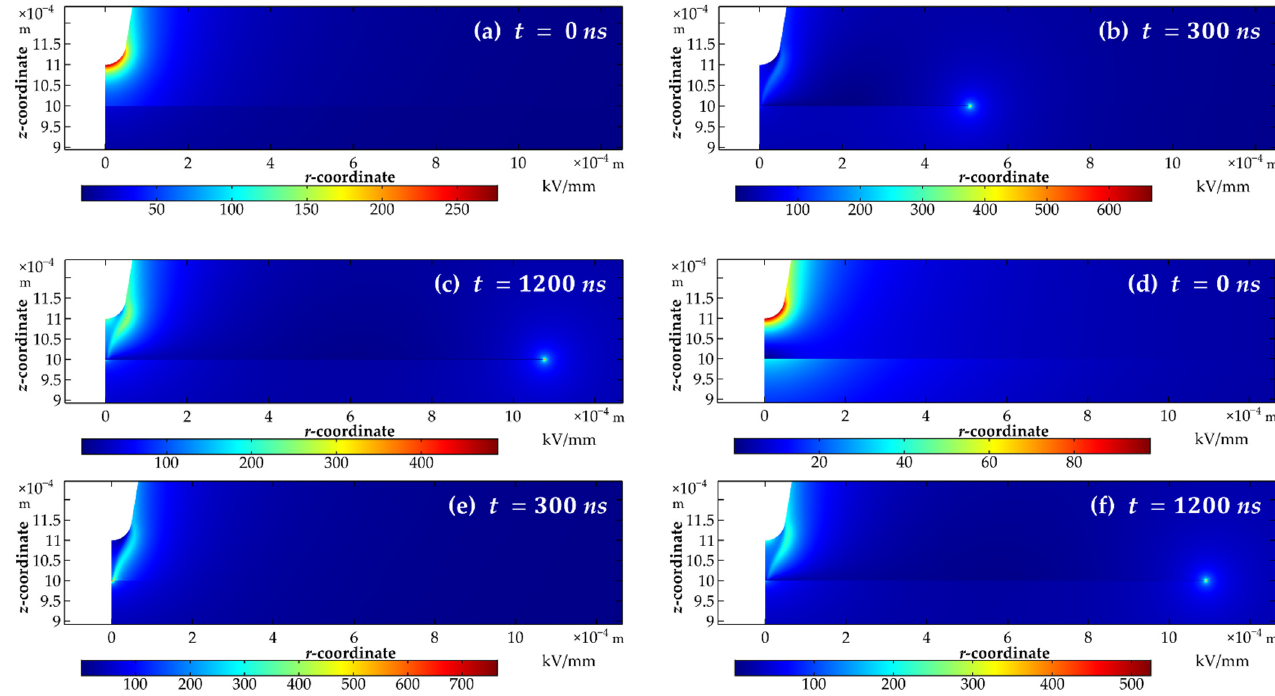
Figure 14. Two-dimensional plane distribution of the electric field magnitude (kV/mm) at different instants: ( a – c ) 1st case; ( d – f ) 2nd case with 𝑉 (cid:3005)(cid:3004) = 20 kV . instants: ( a – c ) 1st case; ( d – f ) 2nd case with V DC = 20